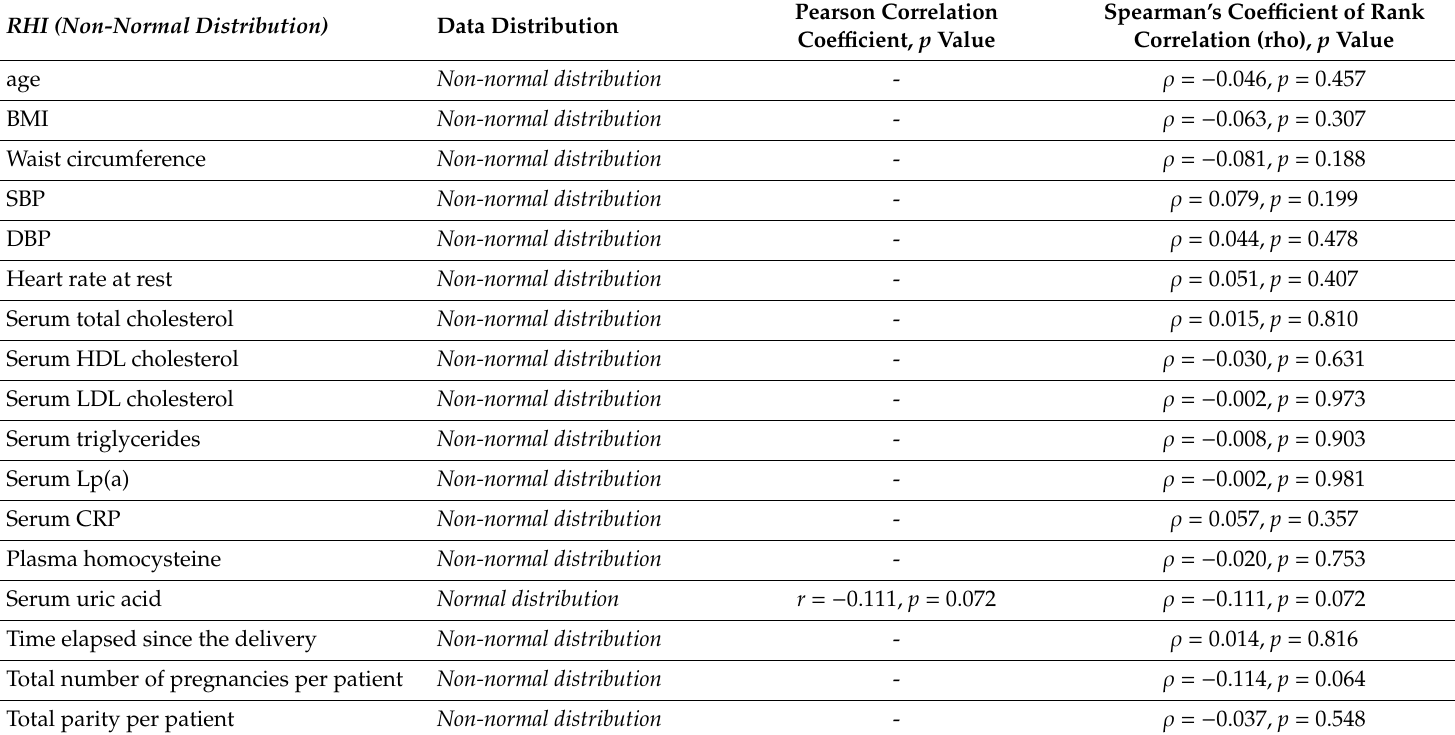
Table 3. Association between the vascular endothelial function (RHI values) and classical cardiovascular risk factors and a history of pregnancy (Pearson correlation coe ffi cient, Spearman’s coe ffi cient of rank